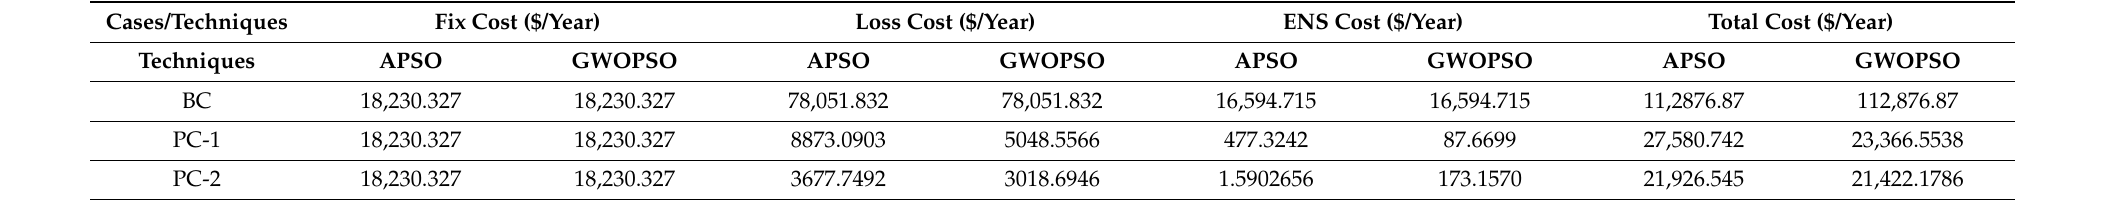
Table 13. The fix, loss, and ENS cost for all the cases of IEEE 69-bus RDN; (a) APSO, (b)